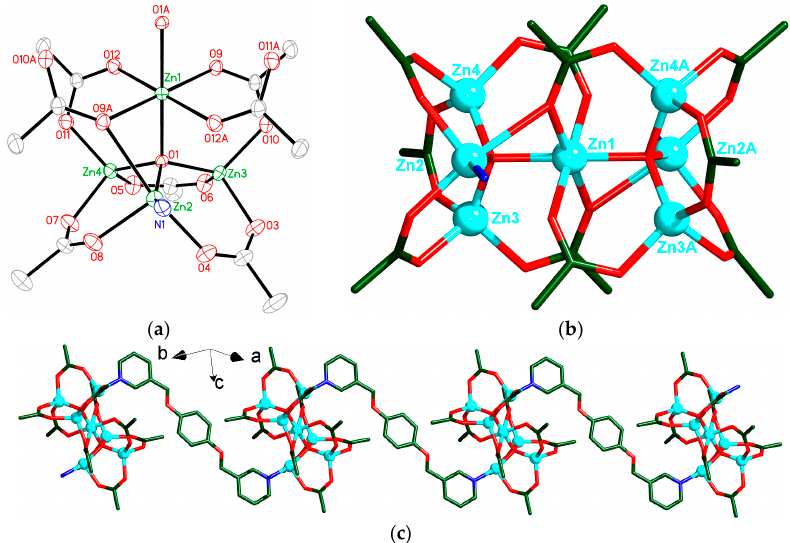
Figure 2. ( a ) View of the coordination environments of Zn centers in 1 with labeling schemes.